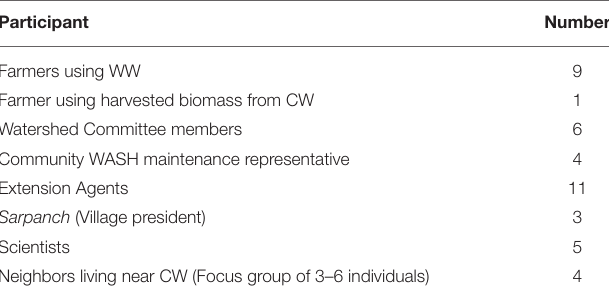
TABLE 1 | Participants by stakeholder group.